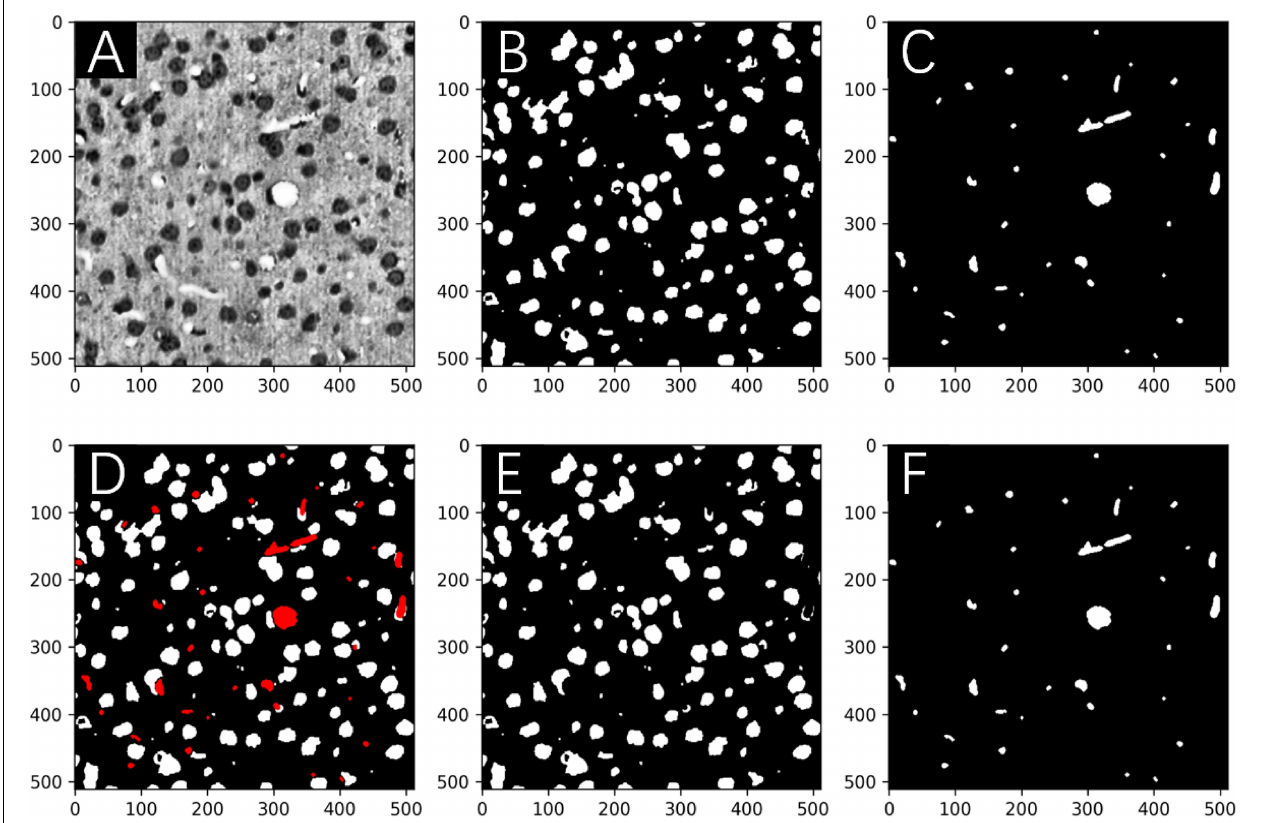
The performance boosting trend is indicated by linear coefficients fitted by the linear regression model for different fusion strategies. Positive values in the linear coefficient indicate a general upward trend, and negative values indicate a downward trend. For comparison, the performance of DDeep3M and multilabel U-Net (trained for 30,000 epochs without fusion and boosting iterations) is also shown. The bold values mean that within the same column, they represent the best results in various experiments.